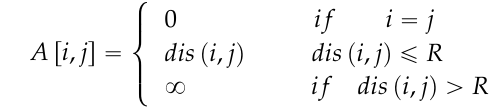
Figure 2. ( a ) Illustration for routing tree; ( b ) Routing recover for mobile moves away; ( c ) Routing recover for relay node failed.